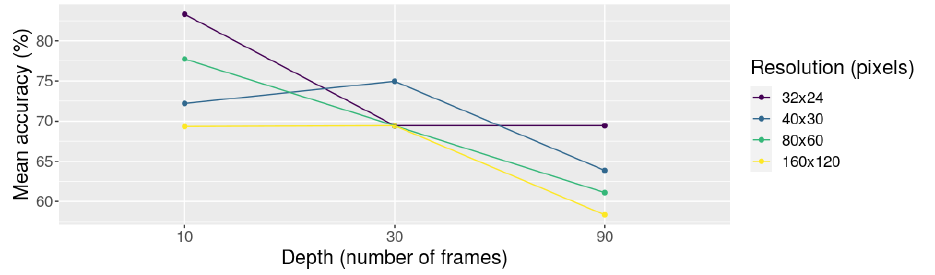
Figure 6. Interaction plot of depth (10, 30, and 90 frames) and resolution (32 × 24, 40 × 30, 80 × 60, and 160 × 120 pixels) using the accuracy values obtained from experiment